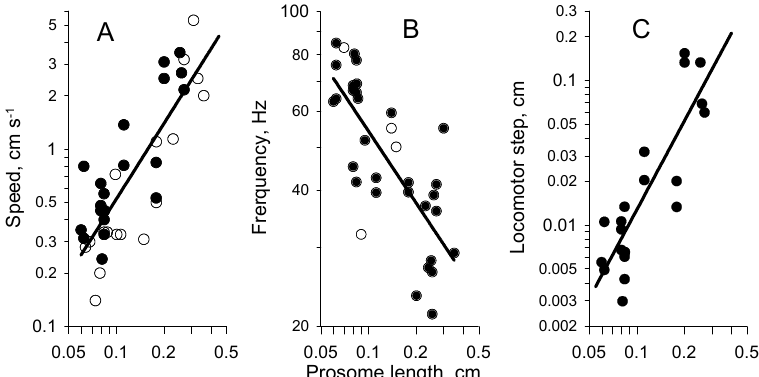
Figure 4. (A ): Regressions of average speed ( U ). ( B ): Limb beat frequency ( F ). ( C ): ‘Locomotor step length’ ( S loc ) versus prosome length ( L ) during cruise swimming (data from Table 2). Black circles are own data obtained from 1200 fps videos. Empty circles are literature data. The power-law regressions were based on all data, U = 13.4 L 1.4 (R 2 = 0.69); F = 16.0 L − 0.53 (R 2 = 0.59); S loc = 1.36 L 2.03 (R 2 = 0.73).